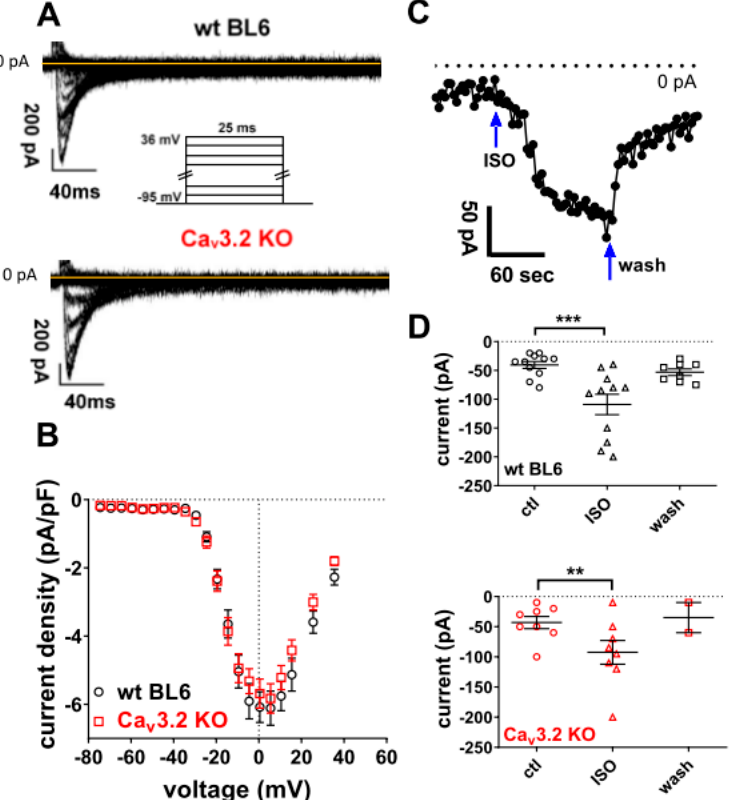
Figure 1. Ca currents in wt and Cav3.2 KO ventricular cardiomyocytes. ( A ) Original traces of Ca currents of a typical wt and Cav3.2 KO myocyte elicited by the pulse protocol displayed on top. ( B ) Current density–voltage relationships of wt (n = 20) and Cav3.2 KO (n = 20) myocytes. Data are expressed as means ± SEM. The current density–voltage relations hardly revealed any T-type Ca channel activity (expected to be maximal at − 45 mV) but did reveal significant L-type Ca channel activity (peaking at +5 mV), which was similar in wt and Cav3.2 KO myocytes ( p = 0.67 at +5 mV, unpaired Student’s t -test). Capacitance values of the examined myocytes were 184 ± 13 pF for wt and 169 ± 11 pF for Cav3.2 KO ( p = 0.37). (C) The effect of the external application of 100 nM iso- prenaline (ISO) on ICaT in a wt myocyte. From a holding potential of − 95 mV, depolarizing voltage steps to − 45 mV were applied every 3 s to elicit the currents. The arrows indicate the beginning and end of ISO application. Current peaks were finally plotted against time. (D) ICaT peaks before, dur- ing application after the steady-state was reached, and after the washout of ISO in wt (top) and Cav3.2 KO (bottom) myocytes. There was no significant difference between wt and Cav3.2 KO un- der control conditions ( p = 0.81, unpaired Student’s t -test) or in the presence of ISO ( p = 0.54). Data are expressed as means ± SEM. Each data point represents a single cell. ** p < 0.01; *** p < 0.001; paired Student’s t -test. Next, we intended to confirm the presence of T-type Ca channels in ventricular car- diomyocytes from adult wt BL/6 mice at the protein level. We performed immunostaining experiments on isolated myocytes, using specific antibodies for Cav3.1 and Cav3.2. Figure 2 shows that both Cav3.1 and Cav3.2 channels were expressed. Cross-striations typical for